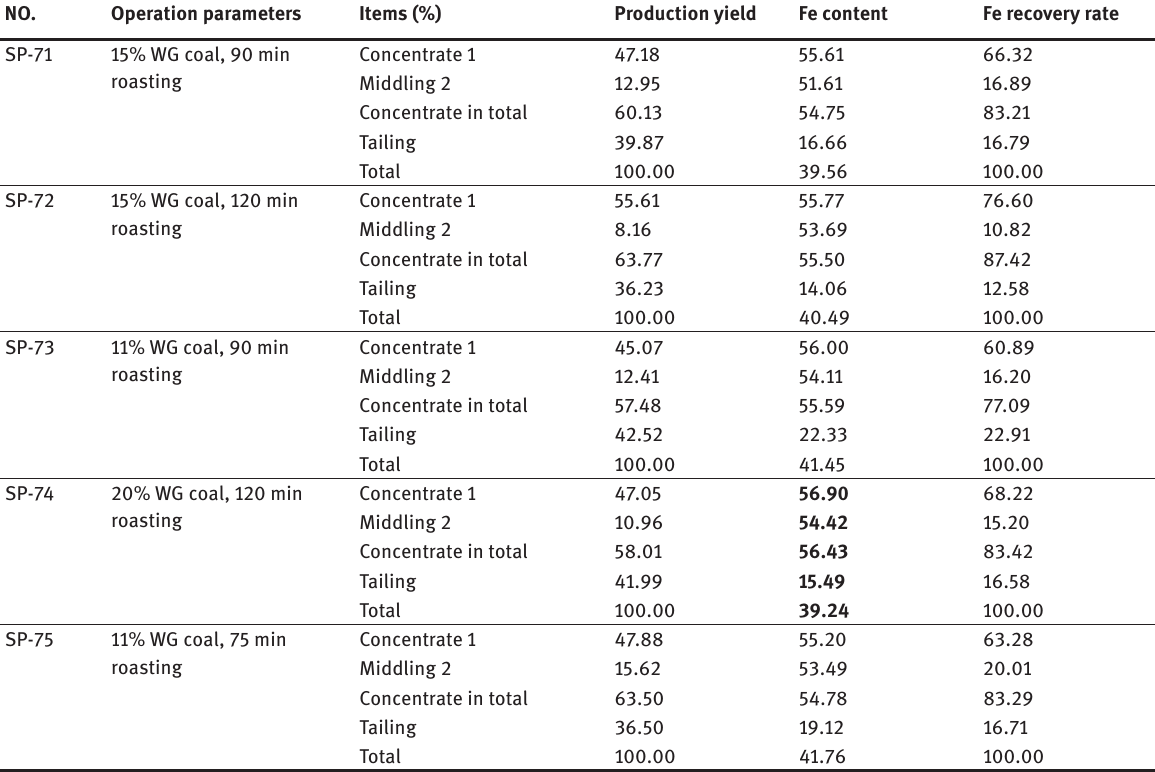
Table 10: Magnetic roasting of SP samples using WG coal at temperature 800 o C, 20 min grinding, magnetic field: 1.5A 0.8A. NO. Operation parameters Items (%) SP-71